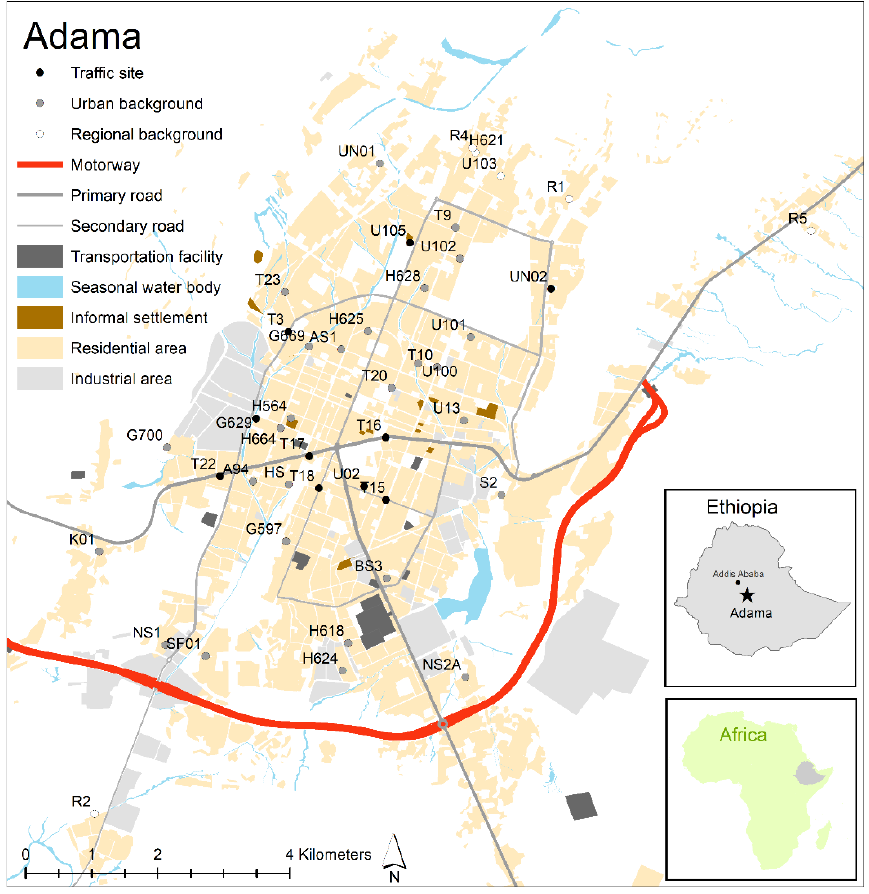
Figure 1. The location of Adama on the East African continent, and the air sampling measurement sites and land use classes included in the LUR models.